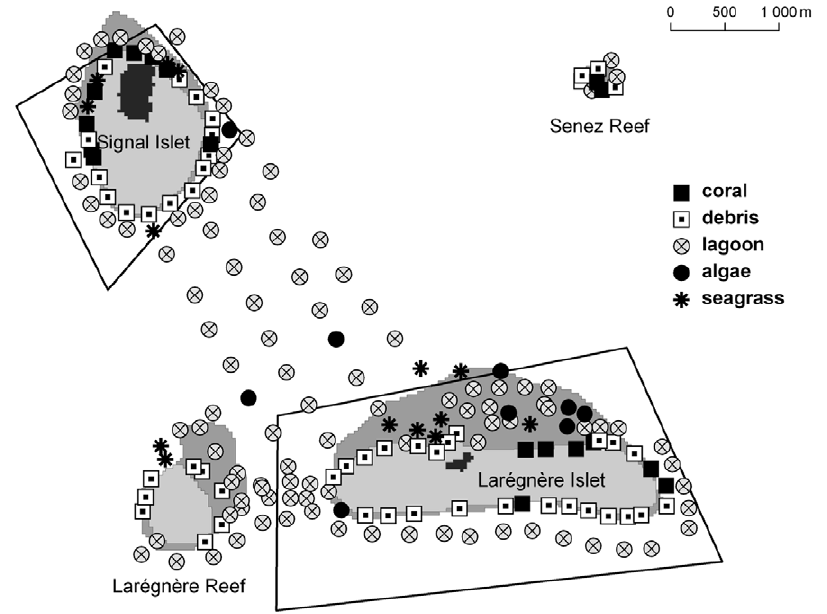
Figure 4. Distribution of habitats resulting from the typology of stations (see legend in insert for symbol definition). Clusters were described in Table 4.